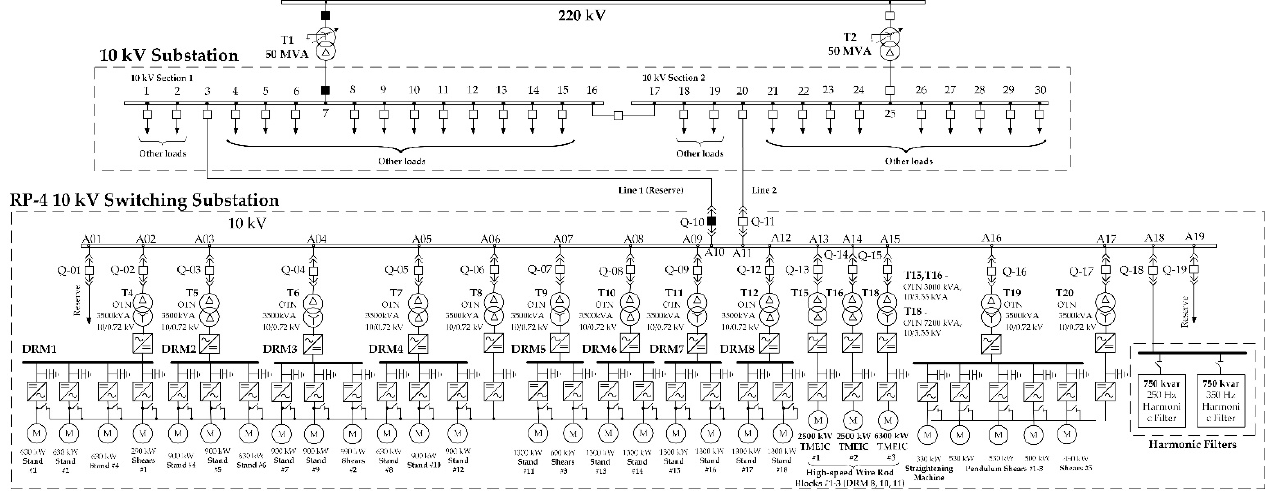
Figure 10. The grid diagram for the key electric drives of the bar mill.